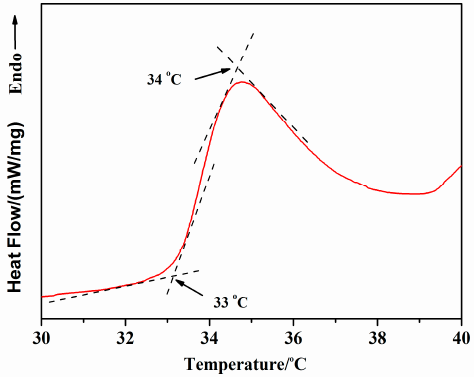
Figure 5. The LCST from a DSC thermogram of PNIPAAm/chitosan hydrogel.